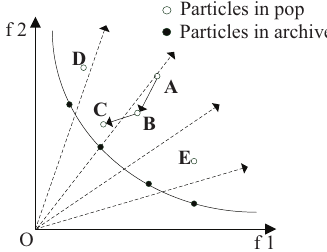
Figure 5. Diagram of particle update by particle swarm optimization using a comprehensive learning strategy (CLPSO).